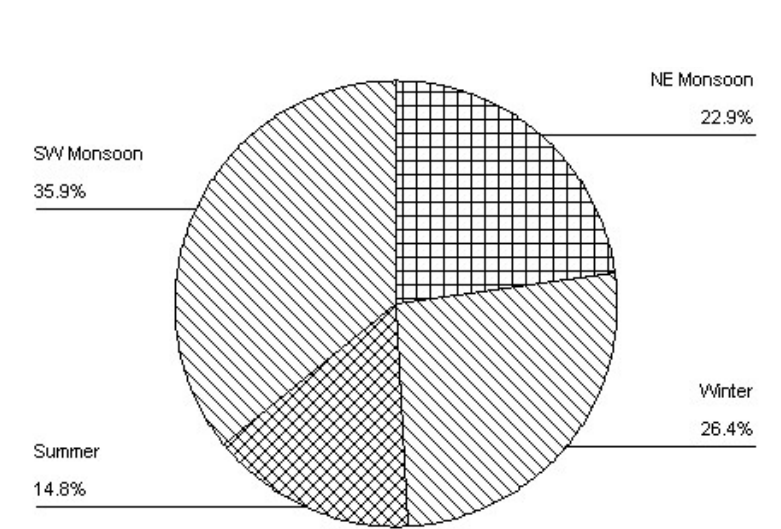
FIGURE 4. Overall seasonal abundance pattern of